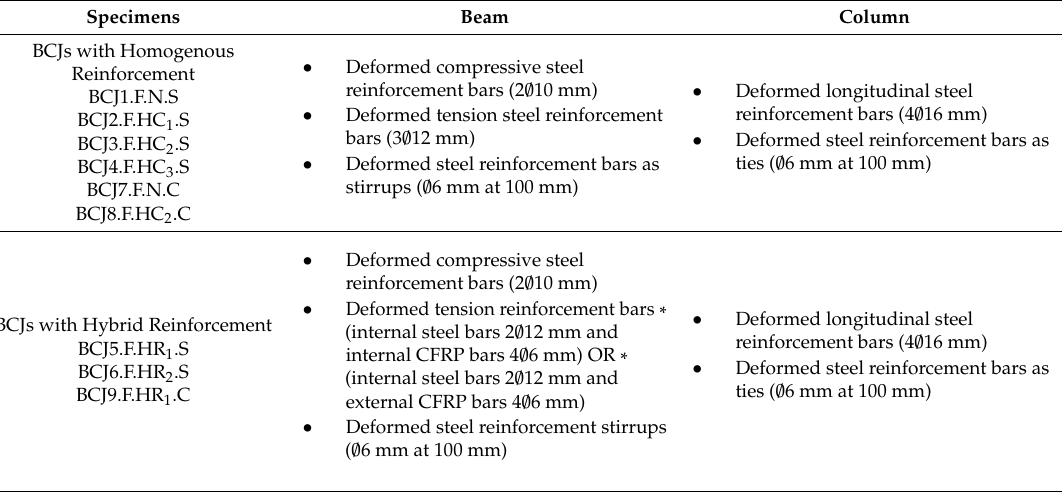
Table 2. Reinforcement arrangement of tested beam-column